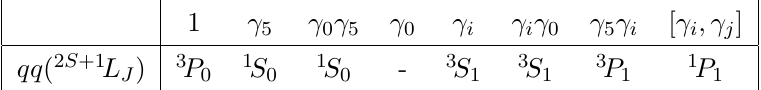
The non-relativistic overlap of the diquark operator (cid:14) J [(cid:0)] onto the diquark state qq ( 2 S +1 L J